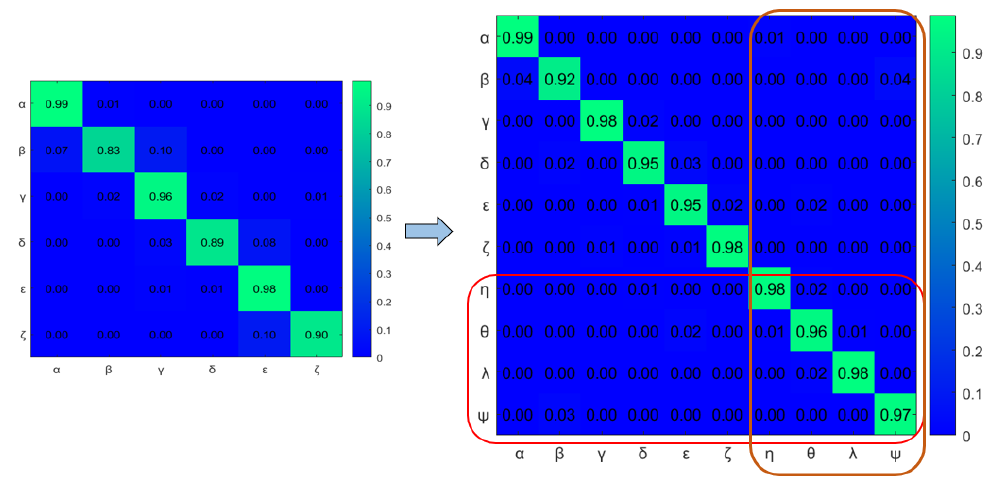
Figure 20. Comparison of joint transition probability matrices between incrementally learned model M 1 and initial model ( M 0 ).